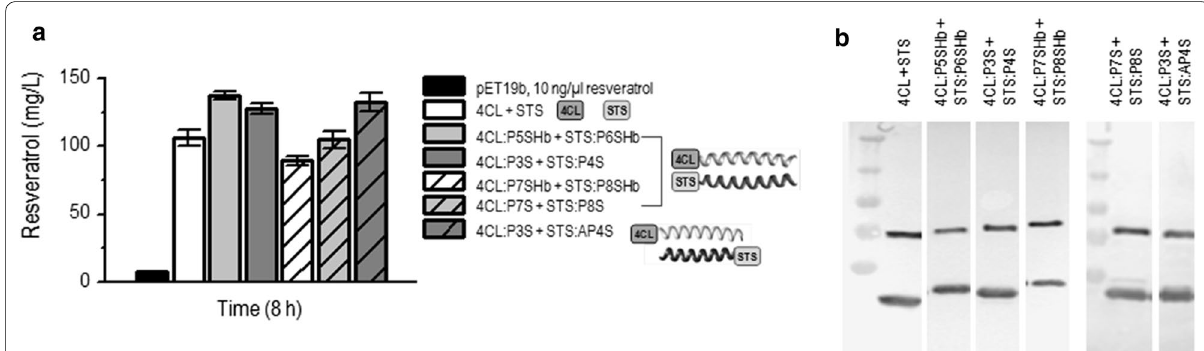
Fig. 4 The clustering of biosynthetic enzymes via coiled-coil-forming domains improves resveratrol production in E. coli . a Enhancement of resveratrol biosynthesis in E. coli after 8 h, depending on the type of coiled-coil-forming domain fused to the enzymes. Simultaneously expressed native enzymes (4CL STS) served as a reference. b The expression of enzymes coupled via coiled-coil-forming domain fusion was determined by + WB. The same protein expression in three representative fermentations is shown in Additional file 1: Fig.